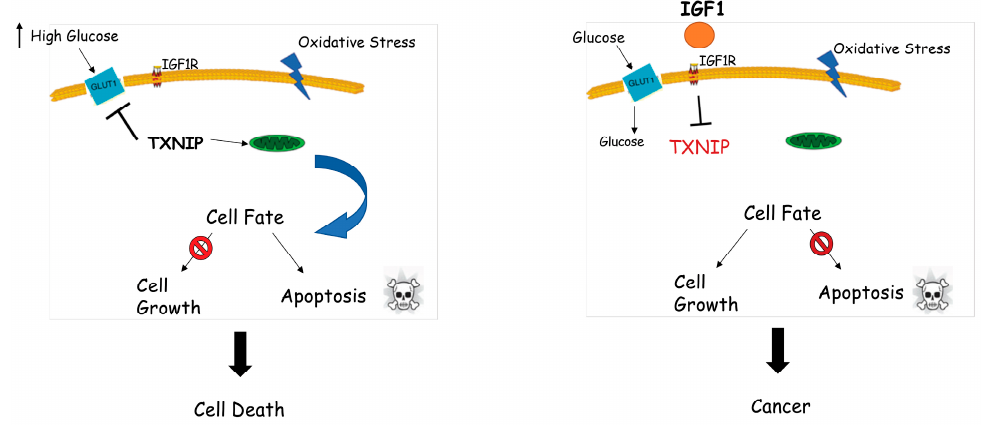
Figure 5. Regulation of thioredoxin-interacting protein (TXNIP) expression by IGF1. The processes of cell survival and homeostasis are tightly controlled by IGF1 action from early ontogenetic stages throughout adulthood. Left panel: normal physiological stress conditions, including starvation and oxidative and glucose stress, might lead to upregulation of TXNIP. Augmented TXNIP levels initiate apoptosis by interacting with thioredoxin and translocating to mitochondria. Cellular stress in the absence of IGF1 (e.g., Laron syndrome) may lead to cell death. Right panel: IGF1 significantly downregulates oxidative and glucose stress-induced TXNIP upregulation and controls glucose uptake in order to improve the energy balance of the cell. Cellular stress in the presence of IGF1 might lead to deregulated cell growth, including